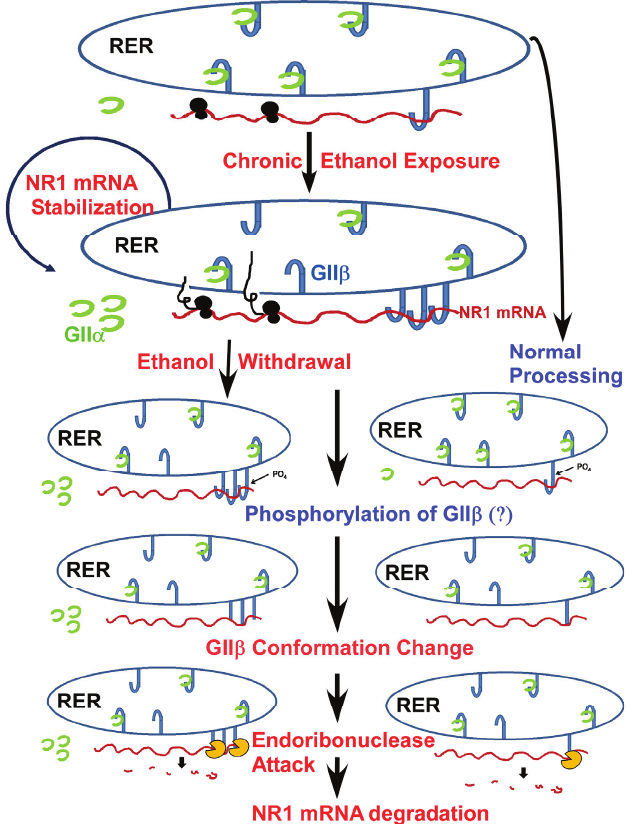
Figure 2. A proposed mechanism of NR1 mRNA regulation in normal and chronic ethanol exposed fetal cortical neurons: The NR1 mRNA is localized in the rough endoplasmic reticulum (RER) irrespective of ethanol treatment [36]. The normal half-life of NR1 mRNA is ~15 h in cultured fetal cortical neurons (FCNs). Following chronic ethanol exposure, the half-life of NR1 mRNA increases to more than 24 h in FCNs [35]. One of the potential mechanisms that can explain increase in NR1 mRNA half-life is increased binding of GII β to NR1 mRNA as demonstrated previously by us [38,39]. Decline in ethanol concentration, e.g., ethanol withdrawal in chronic ethanol exposed FCNs, triggers post-translational modification, e.g., phosphorylation of GII β —a process that occurs in normal FCNs as well. Phosphorylation of GII β alters the protein conformation such that GII β is no longer bound to NR1 mRNA. Loss of interaction with GII β allows NR1 mRNA to become temporarily “naked”. Endoribonclease(s) present in the vicinity are now able to attack the NR1 mRNA, eventually leading to NR1 mRNA